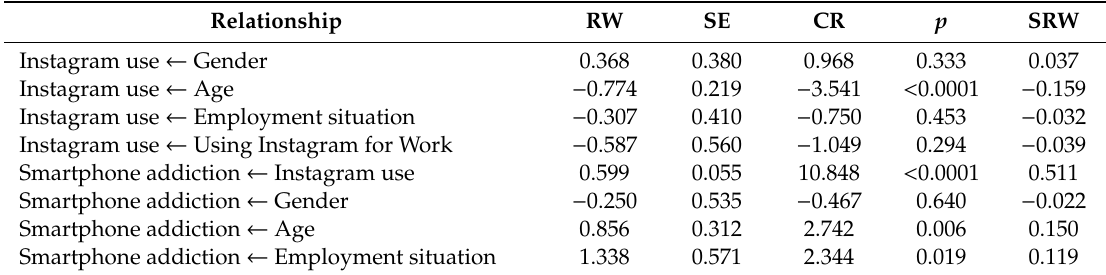
Table 4. Estimates of the parameters of the final model.